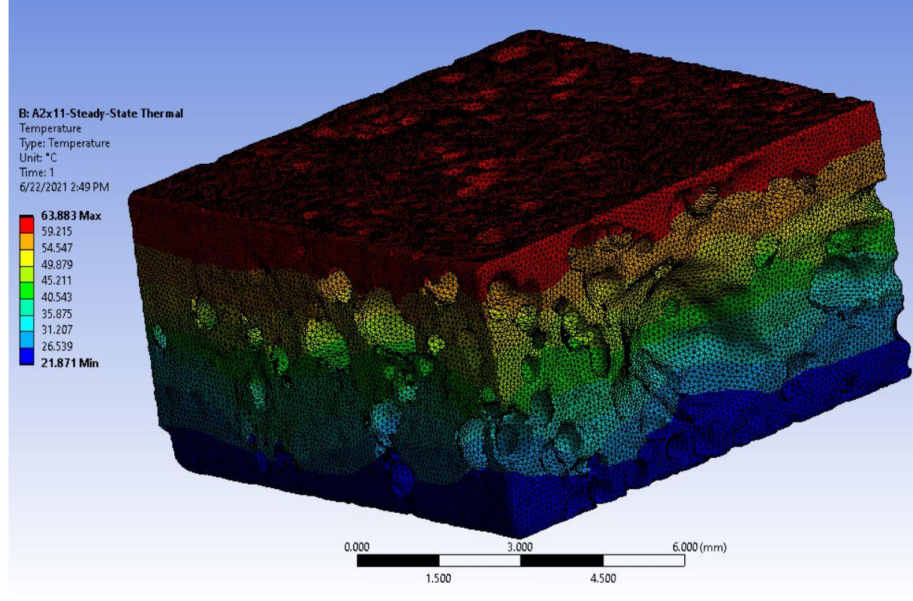
Figure 6. Steady-state one-dimensional conductive heat transfer of the foam model A2 ×